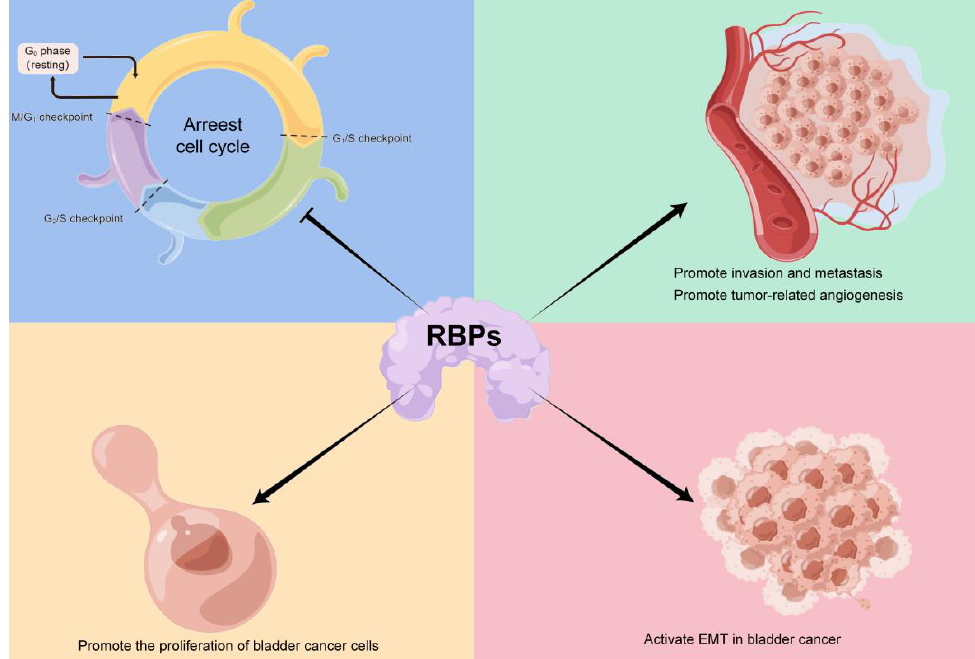
Figure 4. RBPs and bladder cancer. Various RBPs promote bladder cancer progression by promoting bladder cancer proliferation, e.g., HuR can stabilize HOTAIR mRNA; or promoting bladder cancer proliferation and inhibiting apoptosis, invasion, metastasis, e.g., LIN28A/LIN28B; or promoting angiogenesis, e.g., QKI promotes cancer-related fibroblasts to secrete MFAP5, the main component of elastic fibers, to recruit new blood vessels; or activating EMT in bladder cancer. There remain some RBPs that can inhibit clinical progression of bladder cancer by cell cycle blockage, e.g., RBM3 silenced can increase the number of G2/M stage cells and eventually lead to apoptosis or modulation of cell proliferation and invasion. This figure was made using Figdraw .